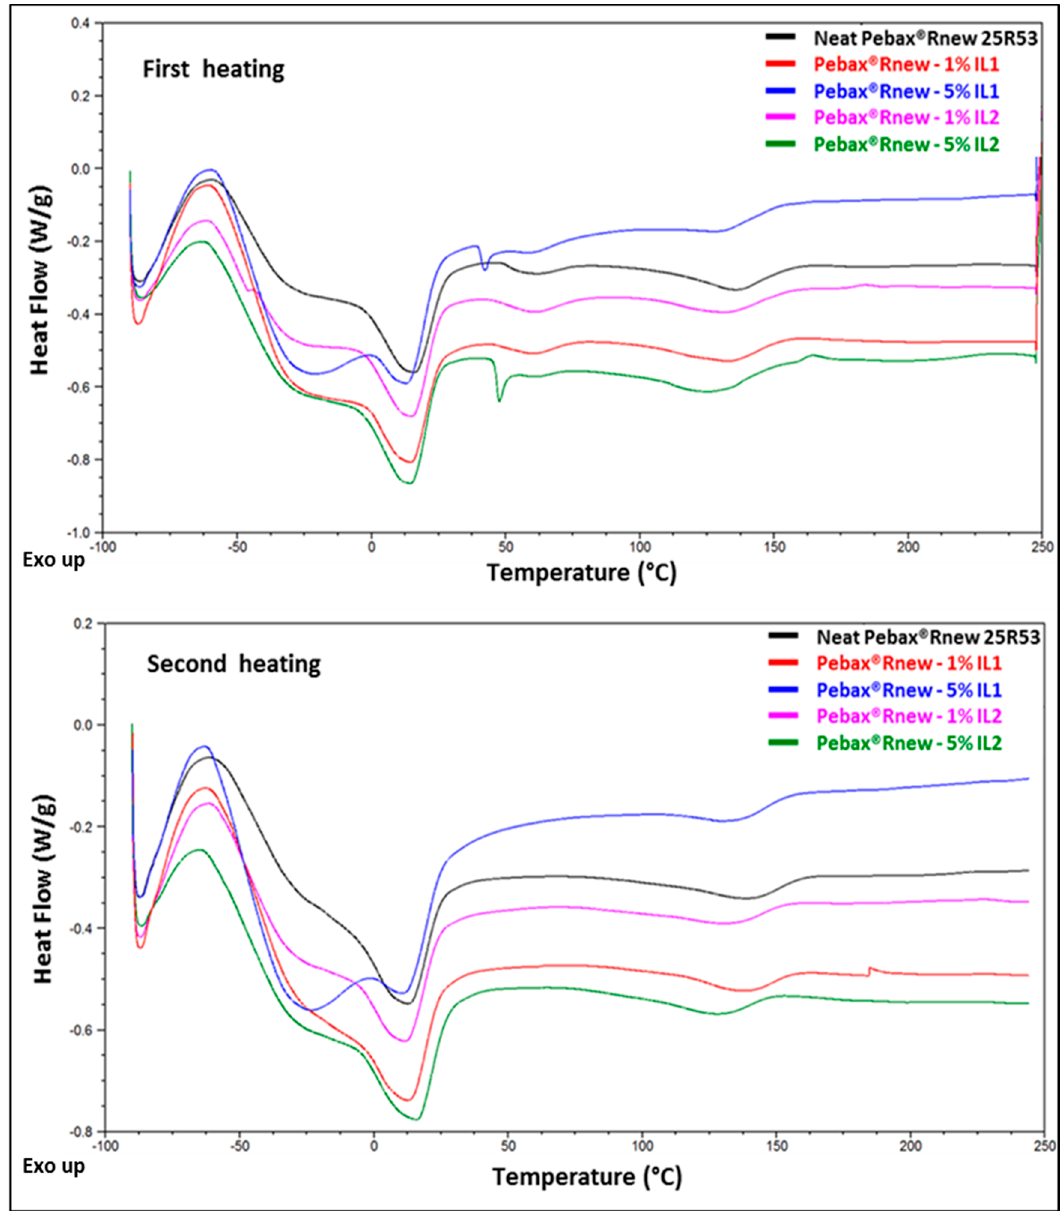
Figure 2. DSC thermograms (first heating and second heating runs) of Pebax ® Rnew and Pebax ® Rnew/ILs blends.